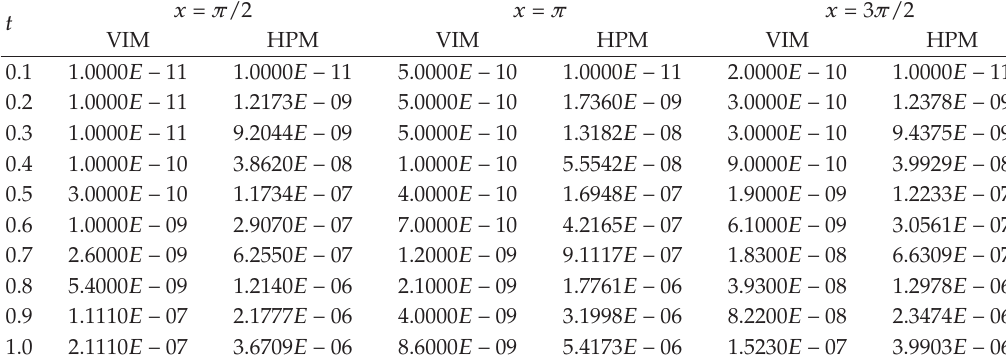
Table 3: Errors of the approximate solution of fractional Rosenau-Hynam equation using using fifth term of HPM and fifth iterate of VIM when α (cid:8) 1 . 0 and c (cid:8) 0 . 5.